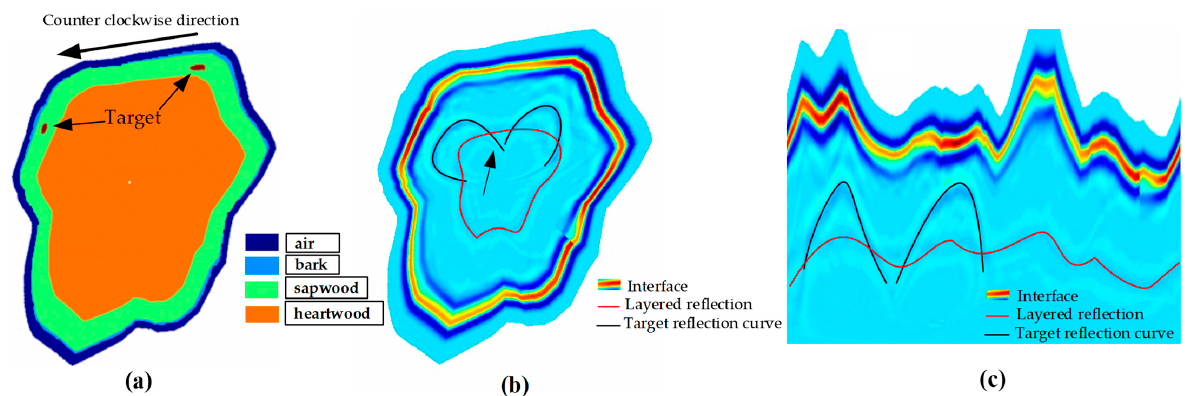
Figure 11. Forward simulation of multiple targets with irregular detection. ( a ) Irregular trunk model with multiple targets; ( b ) radar image of the irregular trunk after the image affine transformation; ( c ) radar images in the irregular physical domain.